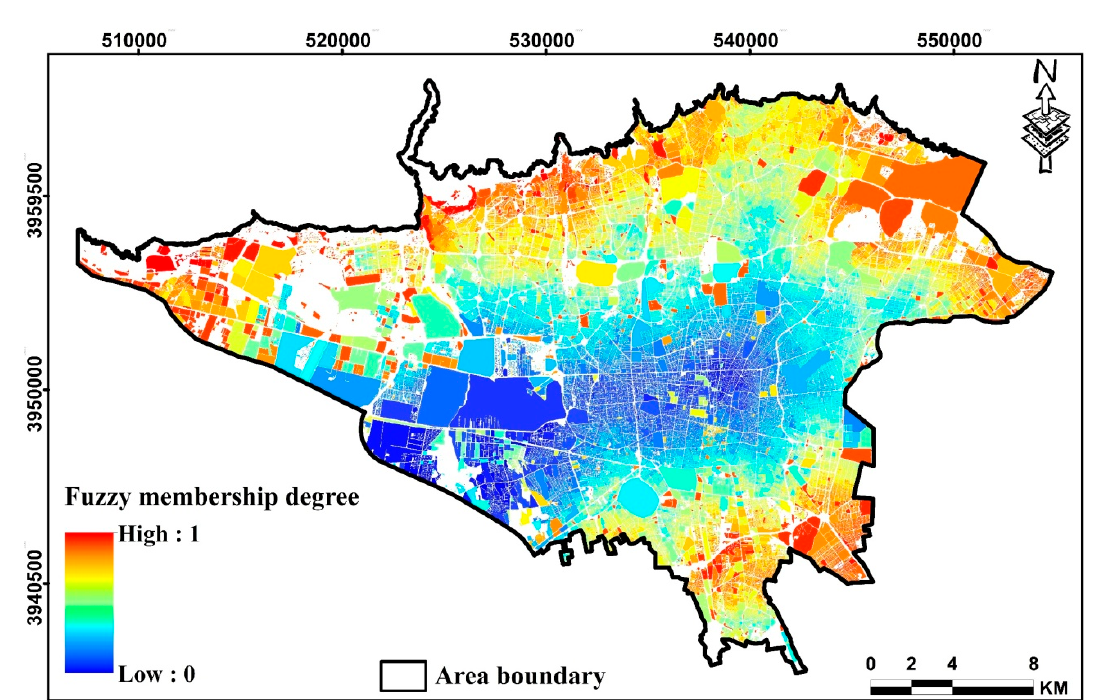
Figure 13. Earthquake vulnerability map over city blocks using ANN-MLP model. Higher degrees of fuzzy membership in this map indicate higher vulnerability.